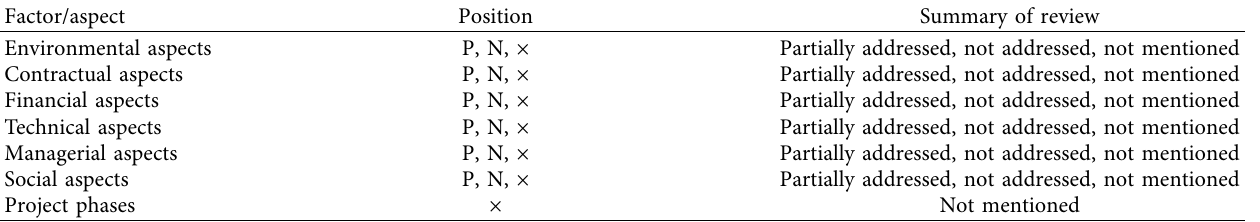
Table 15: Summary of research gaps for construction delay